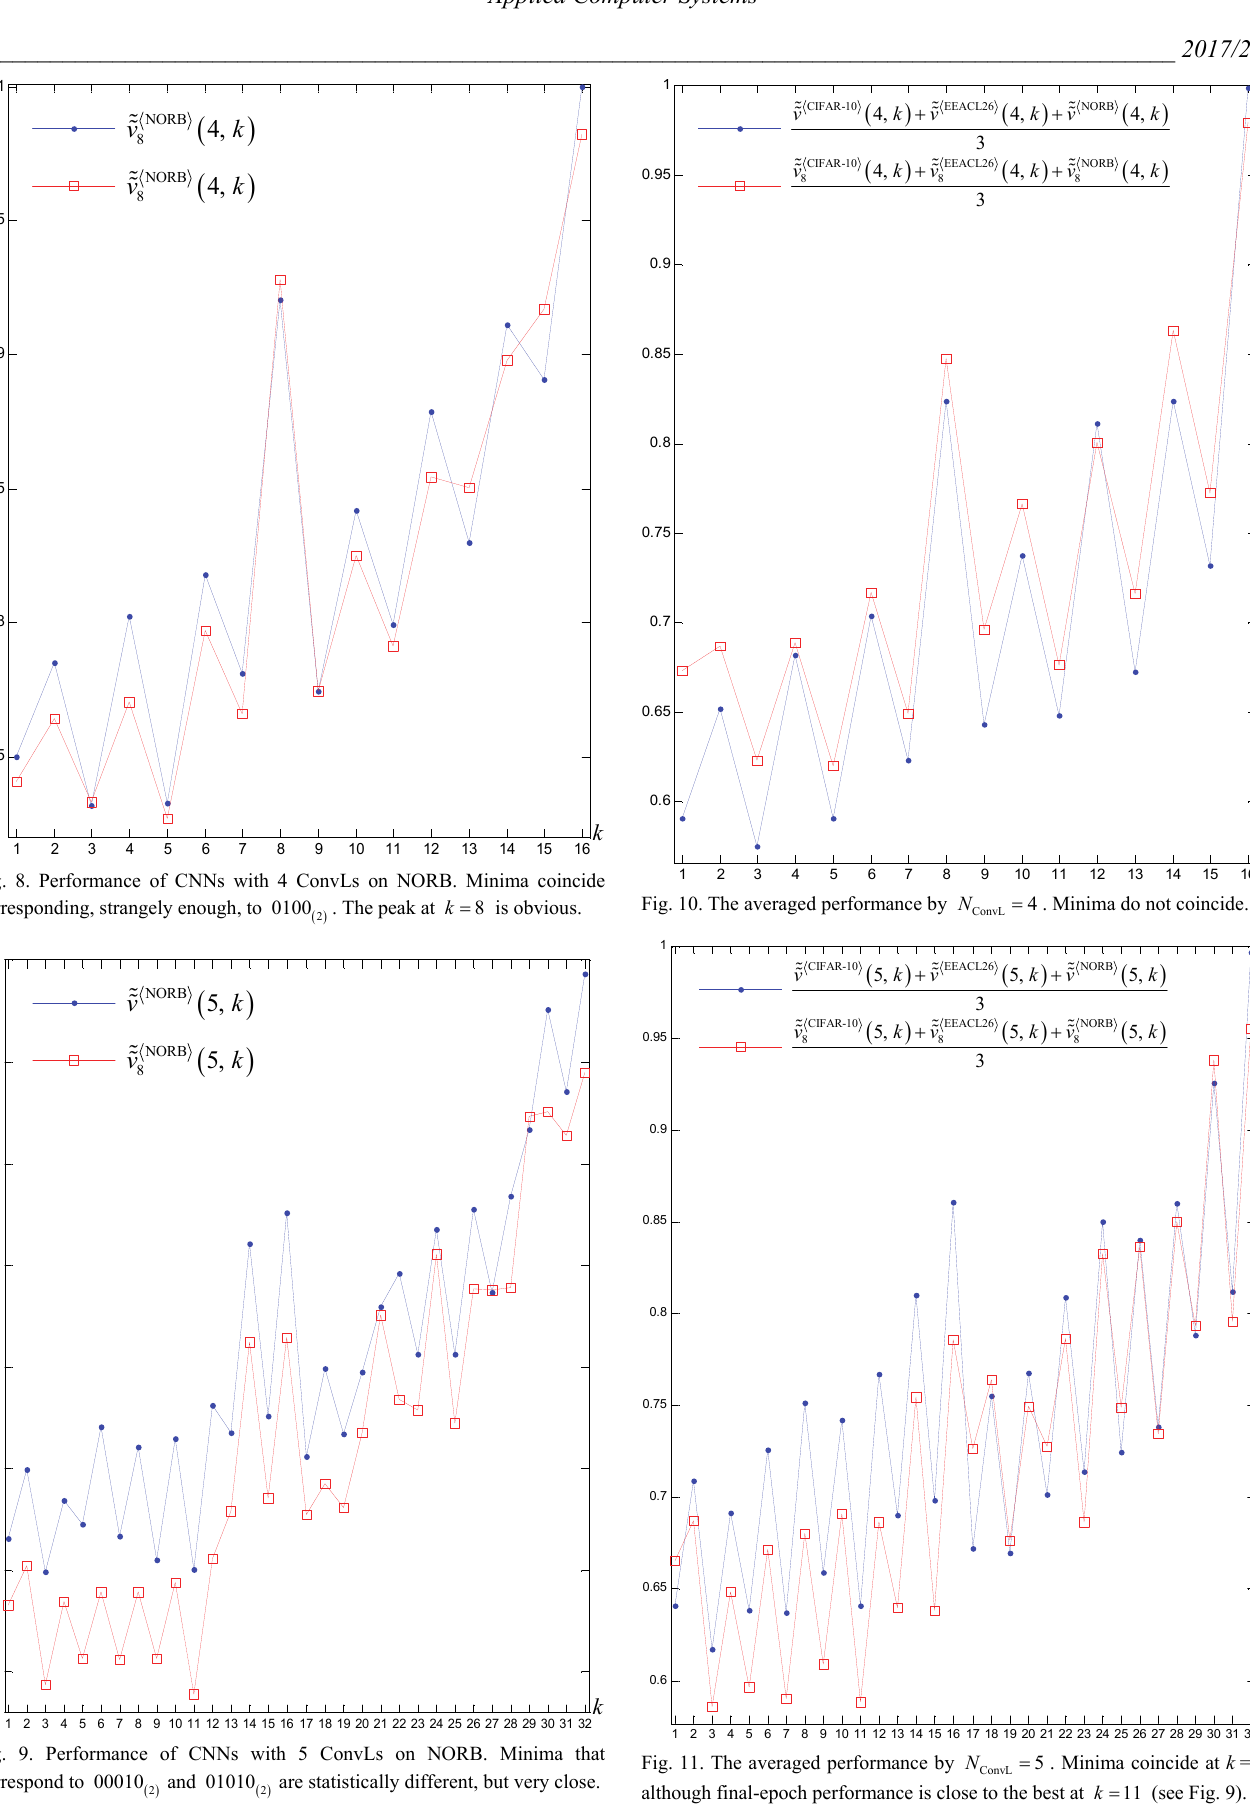
5 N  . Minima coincide at k = 3, ConvL